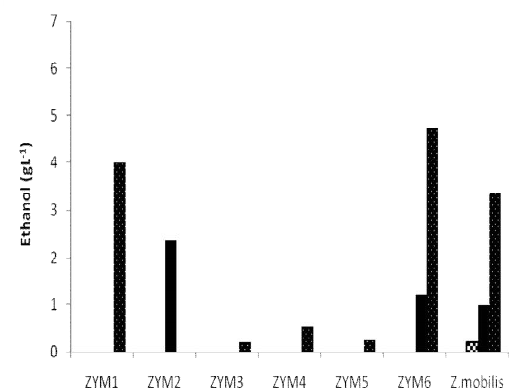
Fig 3. Effect of initial glucose concentration on producing ethanol by isolated bacteria. ( ) 5 g, ( ) 10 g, ( ) 15 g and ( ) 20 g.